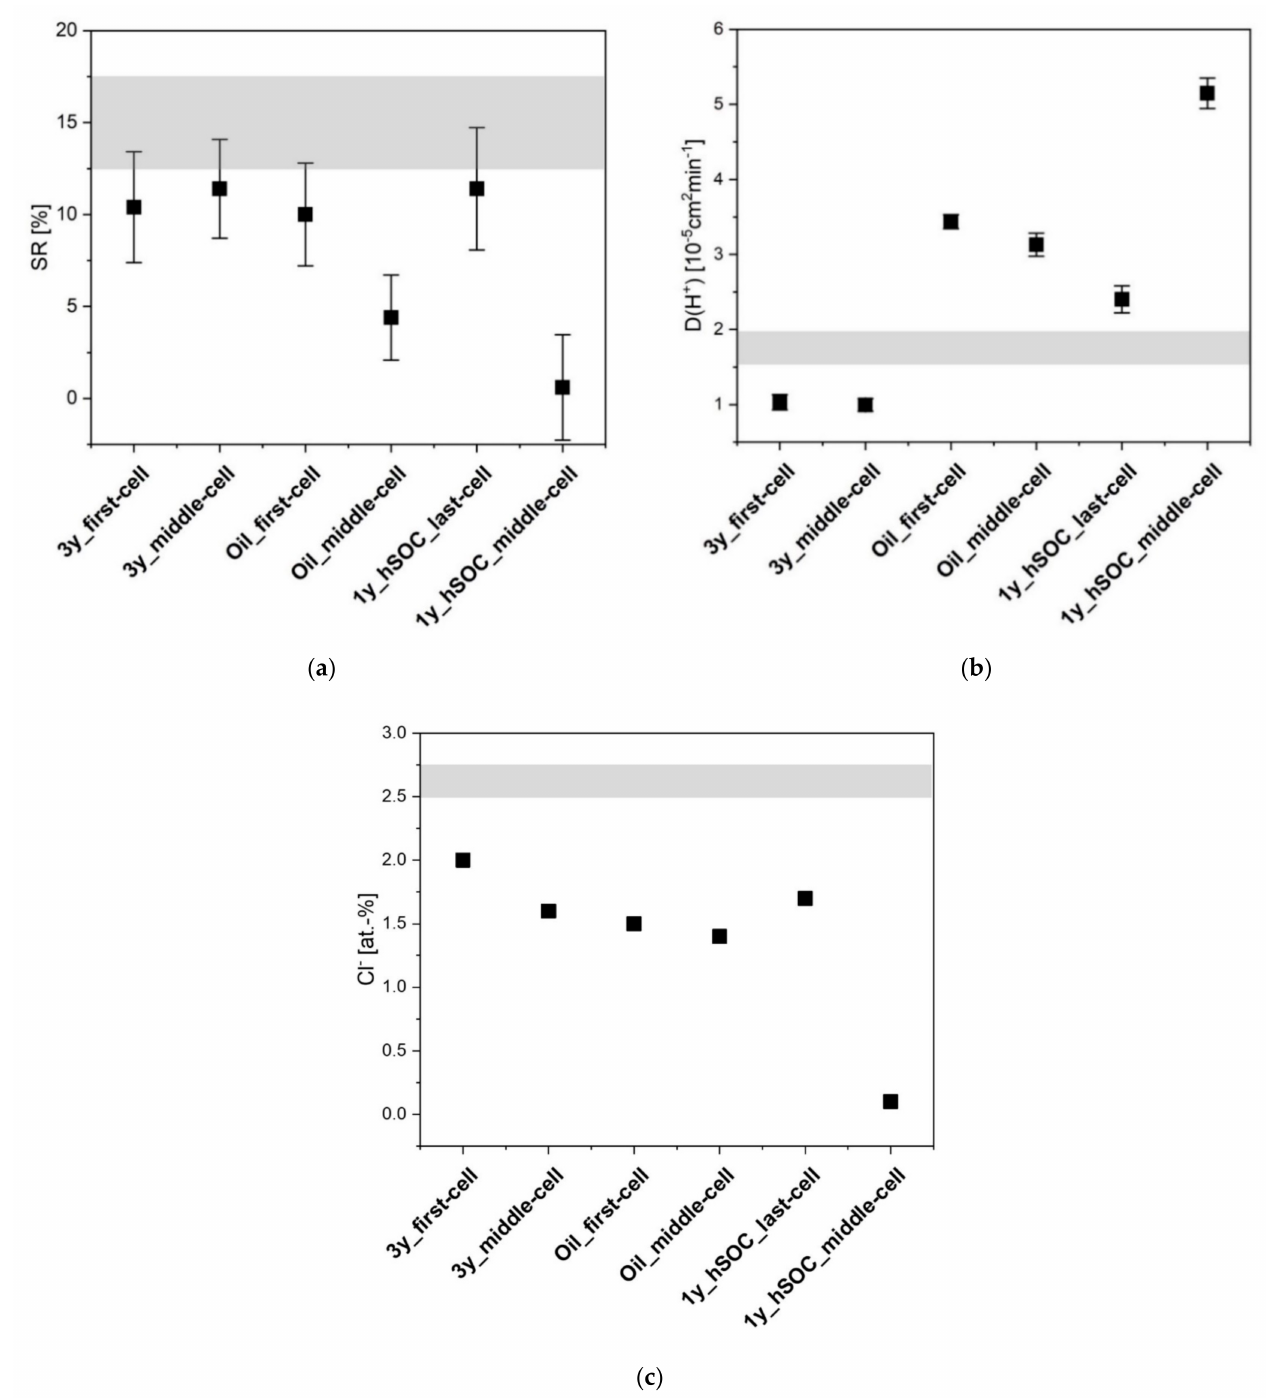
Figure 2. Swelling ratio (SR) ( a ), diffusion coefficients D(H + ) ( b ) and chlorine ratio of membranes ( c ) retrieved from decommissioned stacks; grey zone = pristine; standard deviation (SD) of swelling ratio includes 10 values and SD of D includes 3